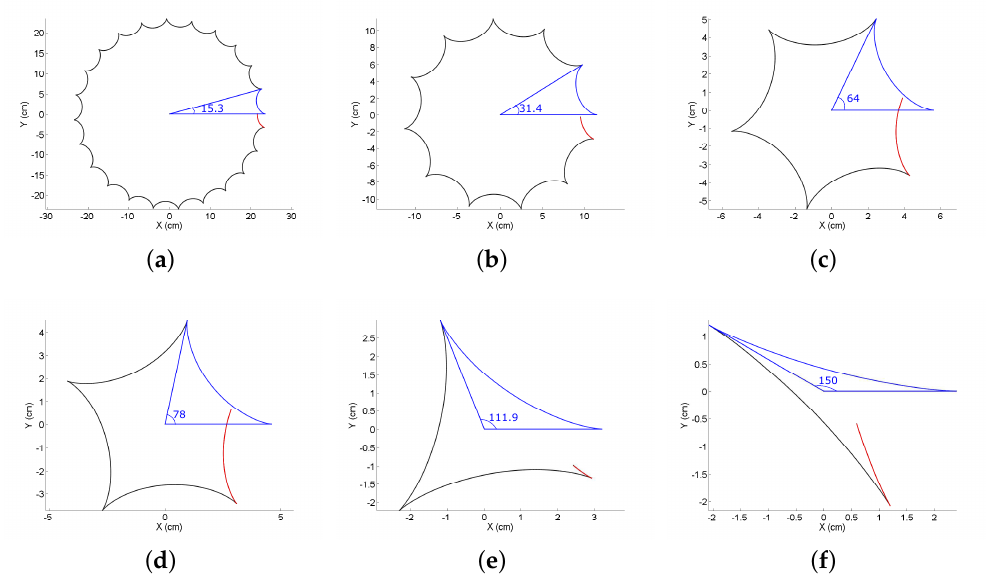
Figure 8. SHP [117] generation with different angles. The first segment of the curve in blue is taken to generate SHP, whereas other curve segments in black and red are ignored. ( a ) θ = 15.3°. ( b ) θ = 31.4°. ( c ) θ = 64°. ( d ) θ = 78°. ( e ) θ = 111.9°. ( f ) θ =